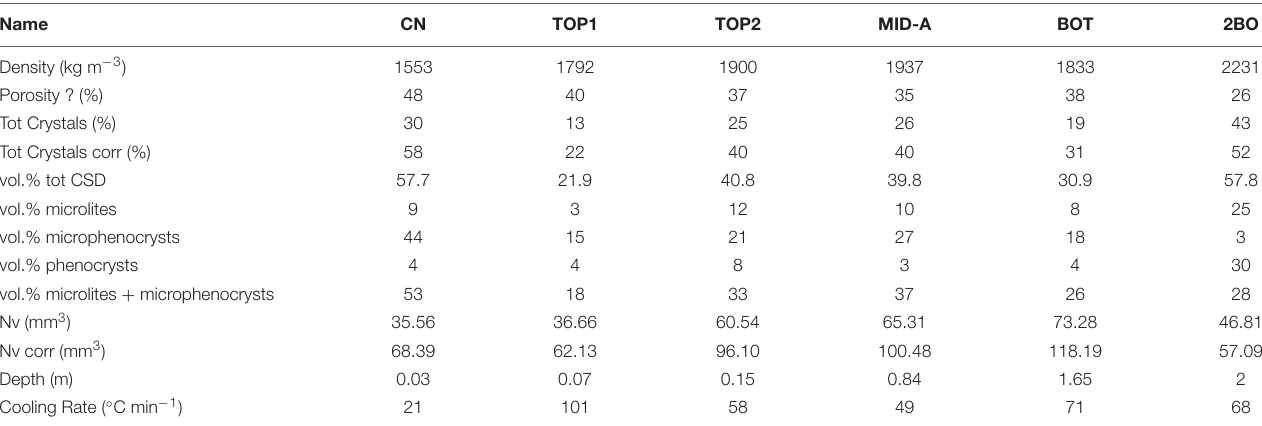
TABLE 1 | Summary table for textural parameters measured in this